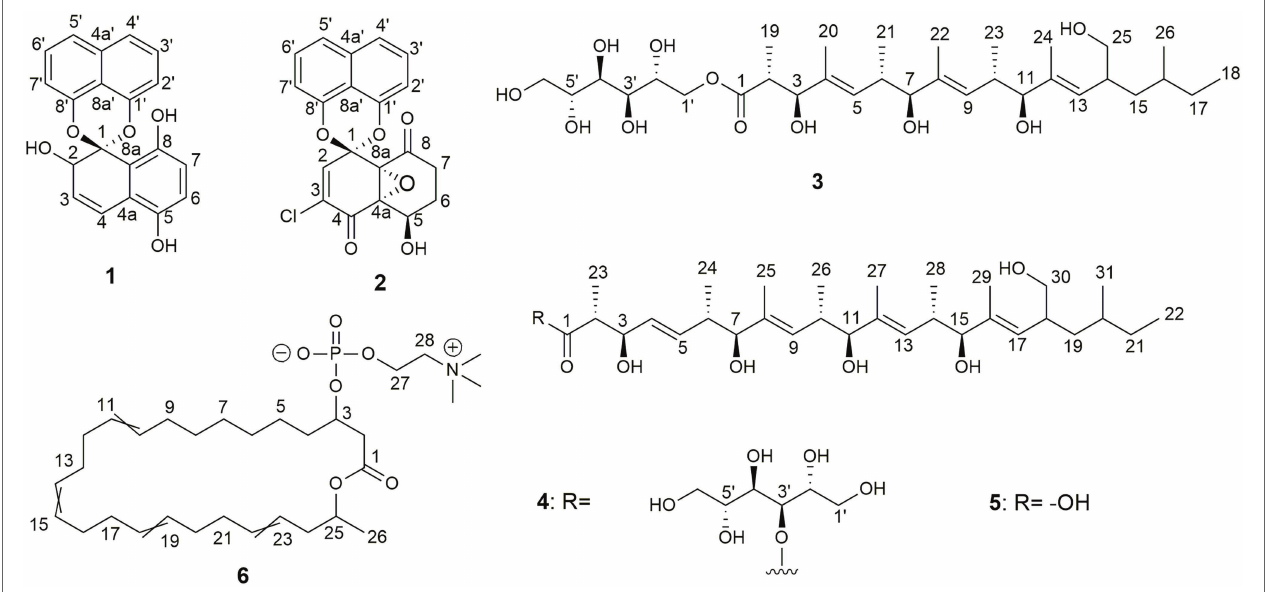
FIGURE 6 | Chemical structures of palmarumycin CP 30 ( 1 ) and palmarumycin C 8 ( 2 ), muyocopronol A ( 3 ), B ( 4 ), and C ( 5 ), and tropicicolide ( 6 ) that were isolated from strains, Lophiotrema sp. F6932, Muyocopron laterale F5912, and Colletotrichum tropicicola